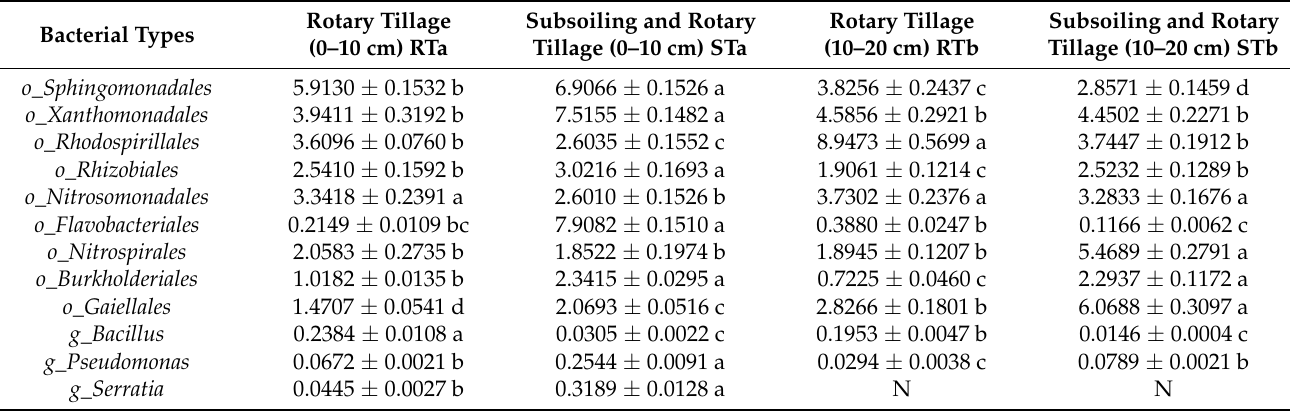
Table 1. Comparison of the dominant bacterial orders and typical bacterial genera and at order and genus levels (%) in different treatments.